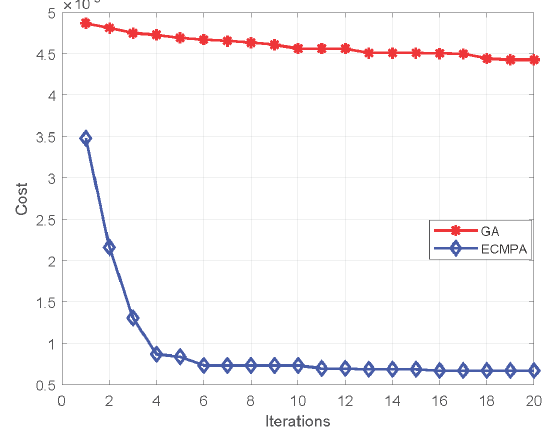
Figure 5: Classification results of proposed WBCs classification system In Figure 6, the convergence of proposed ECMPA is compared with classical population based metaheuristic i.e. Genetic Algorithm (GA). The graph demonstrates that ECMPA achieves a better value of cost function with a smaller number of iterations.